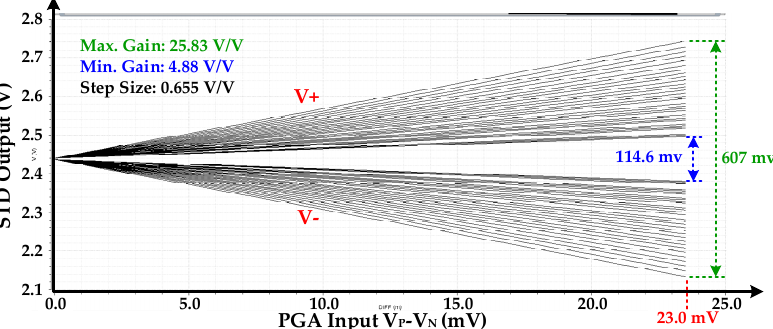
Figure 15. Programmable gain amplifier (PGA) simulation results at different gain including STD.